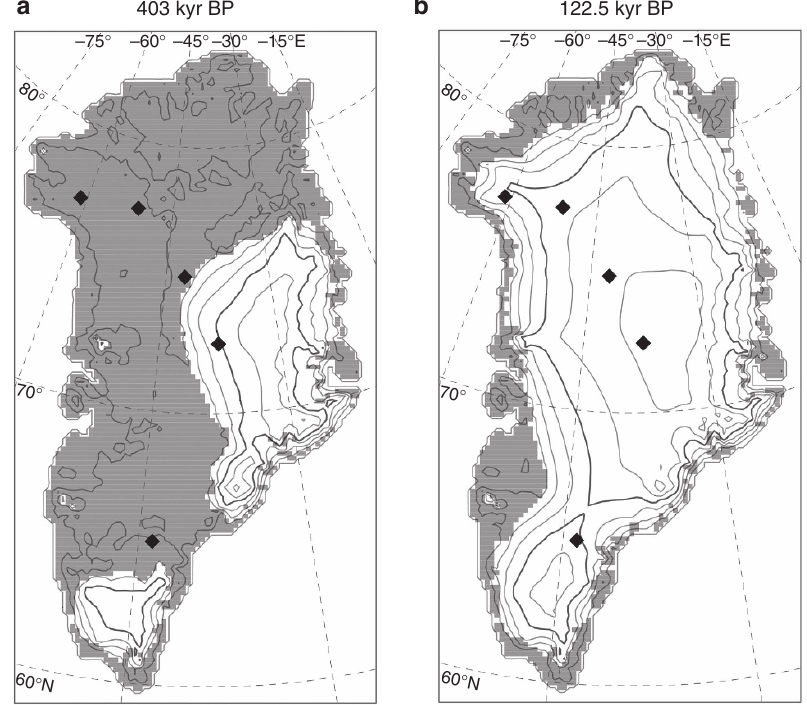
Figure 5 | MIS-11 and MIS-5e ice sheet distributions. Minimum ice sheet distribution for MIS-11 ( a ) and MIS-5e ( b ) given the same model parameters (melt parameter c ¼ (cid:2) 55Wm (cid:2) 2 , precipitation sensitivity d P /d T ¼ 7.1% (cid:2) C (cid:2) 1 ), and the same climatic scaling factor applied to the temperature anomalies used to force the regional climate–ice sheet model. Black diamonds show the following ice core locations from North to South: Camp Century, NEEM, NGRIP, GRIP and DYE-3. The peak simulated summer temperature anomaly during MIS-11 and MIS-5 in this simulation was 2.8 and 2.1 (cid:2) C,